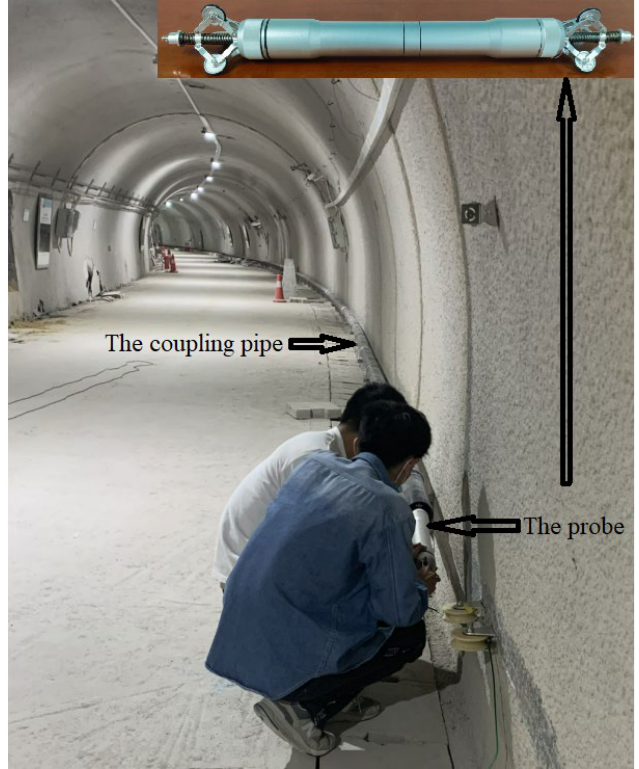
Figure 14. Field test.